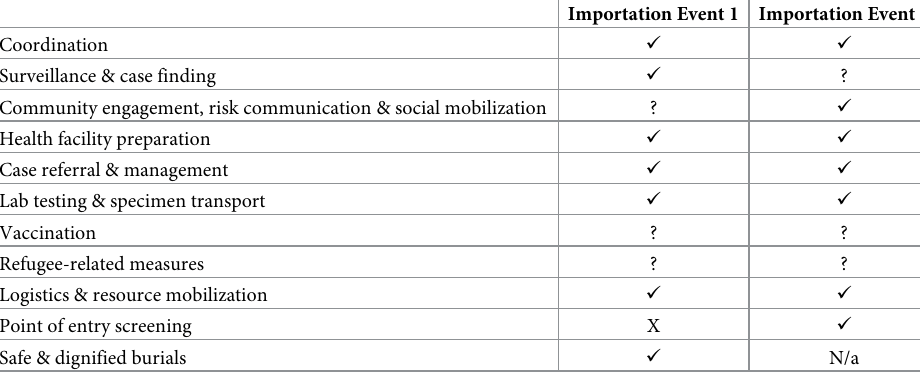
Table 4. Summary of framework evaluation